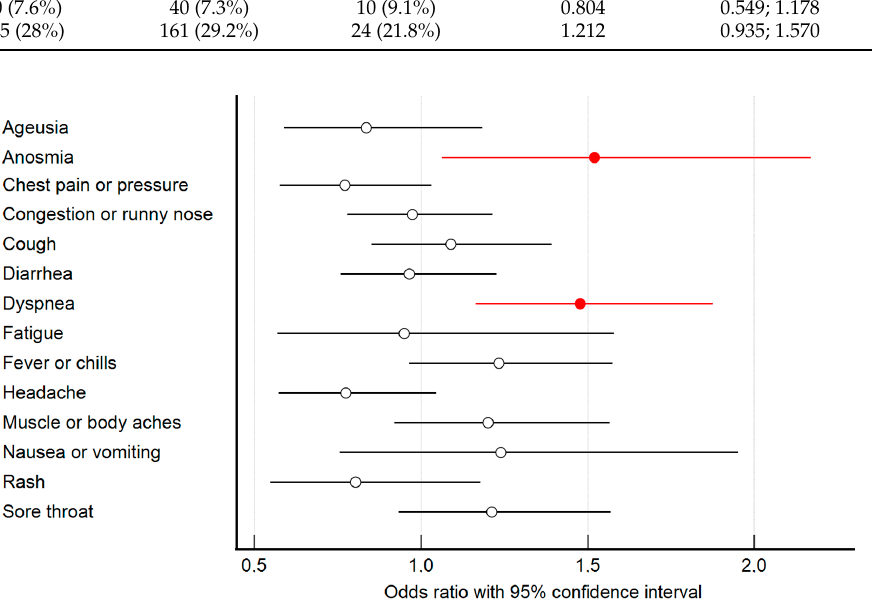
Figure 1. Size effect of each symptom on the seropositivity rate. Statistically significant effects highlighted in red.